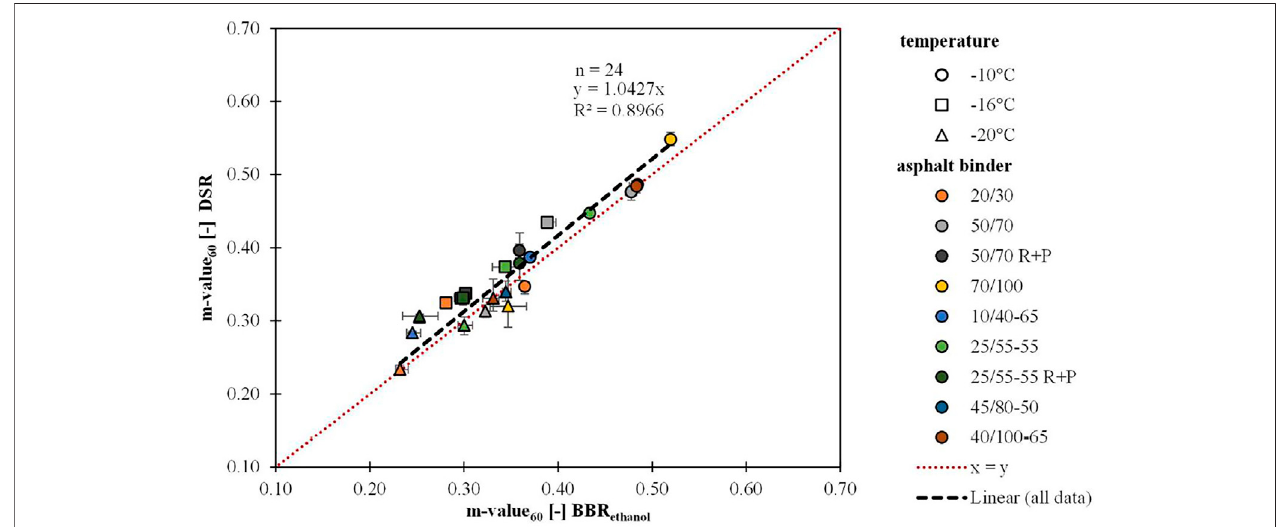
FIGURE 12 | Correlating m-values 60 obtained from BBR tests and DSR tests.